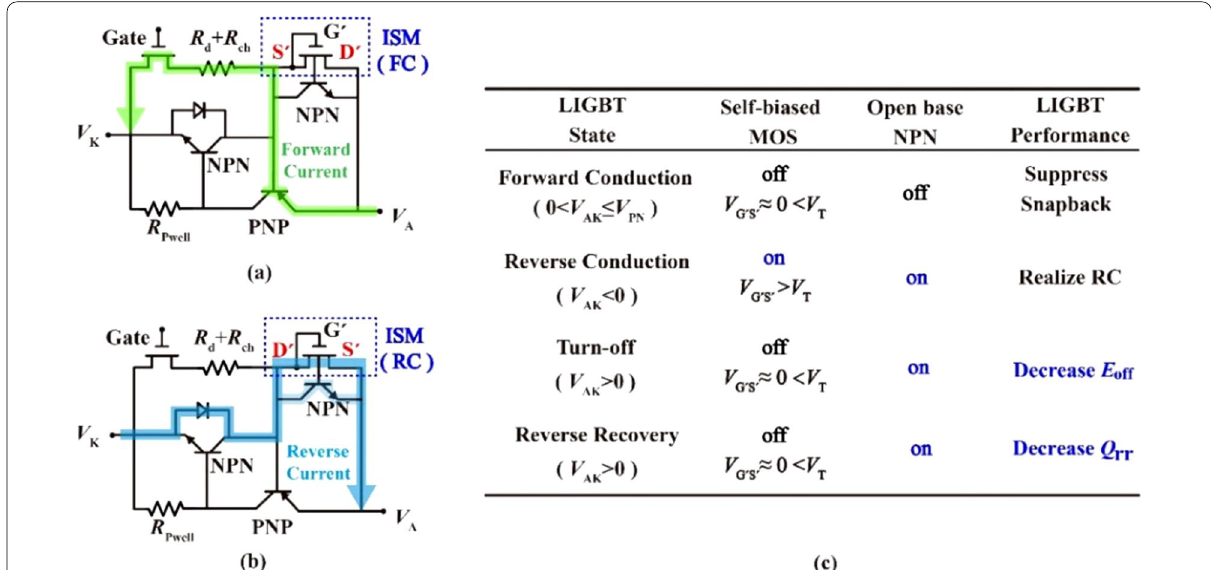
Fig. 2 Equivalent circuit of the ISM RC-IGBT for a FC state and b RC state. c States of the ISM under different operation states of LIGBT. Here V PN is the built-in potential of P /N-buffer junction, V T is the threshold voltage of the self-biased MOS +